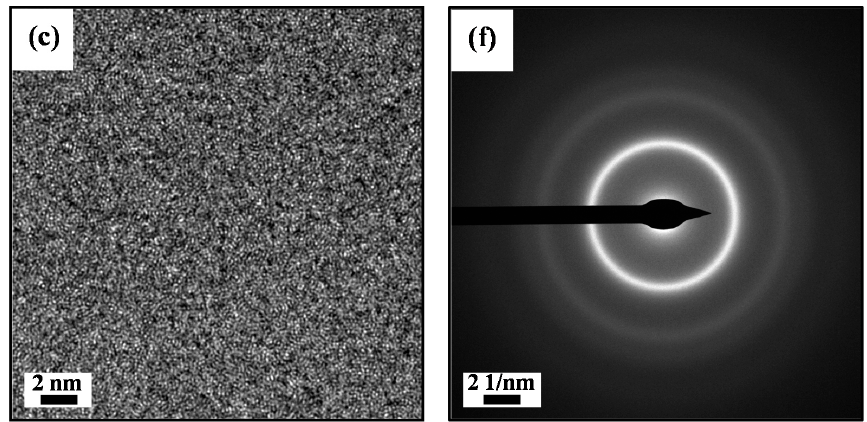
Figure 2. The transmission electron microscopy (TEM) images of the as-spun ( a ) Zr0, ( b ) Zr0.5 and ( c ) Zr1 ribbons, the SAED (Selected area electron diffraction)patterns of the as-spun ( d ) Zr0, ( e ) Zr0.5 and ( f ) Zr1 ribbons.